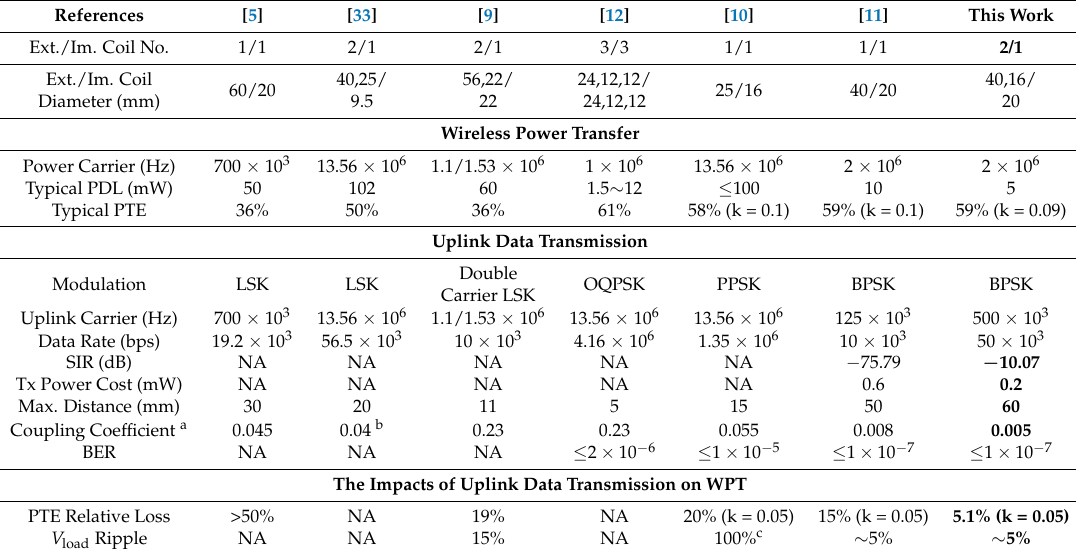
Table 2. Performance comparison. PDL, power delivered to the load; LSK, load-shift keying; PPSK, passive phase shift keying; OQPSK, offset quadrature phase shift keying; WPT, wireless power transmission; Ext., external; Im.,